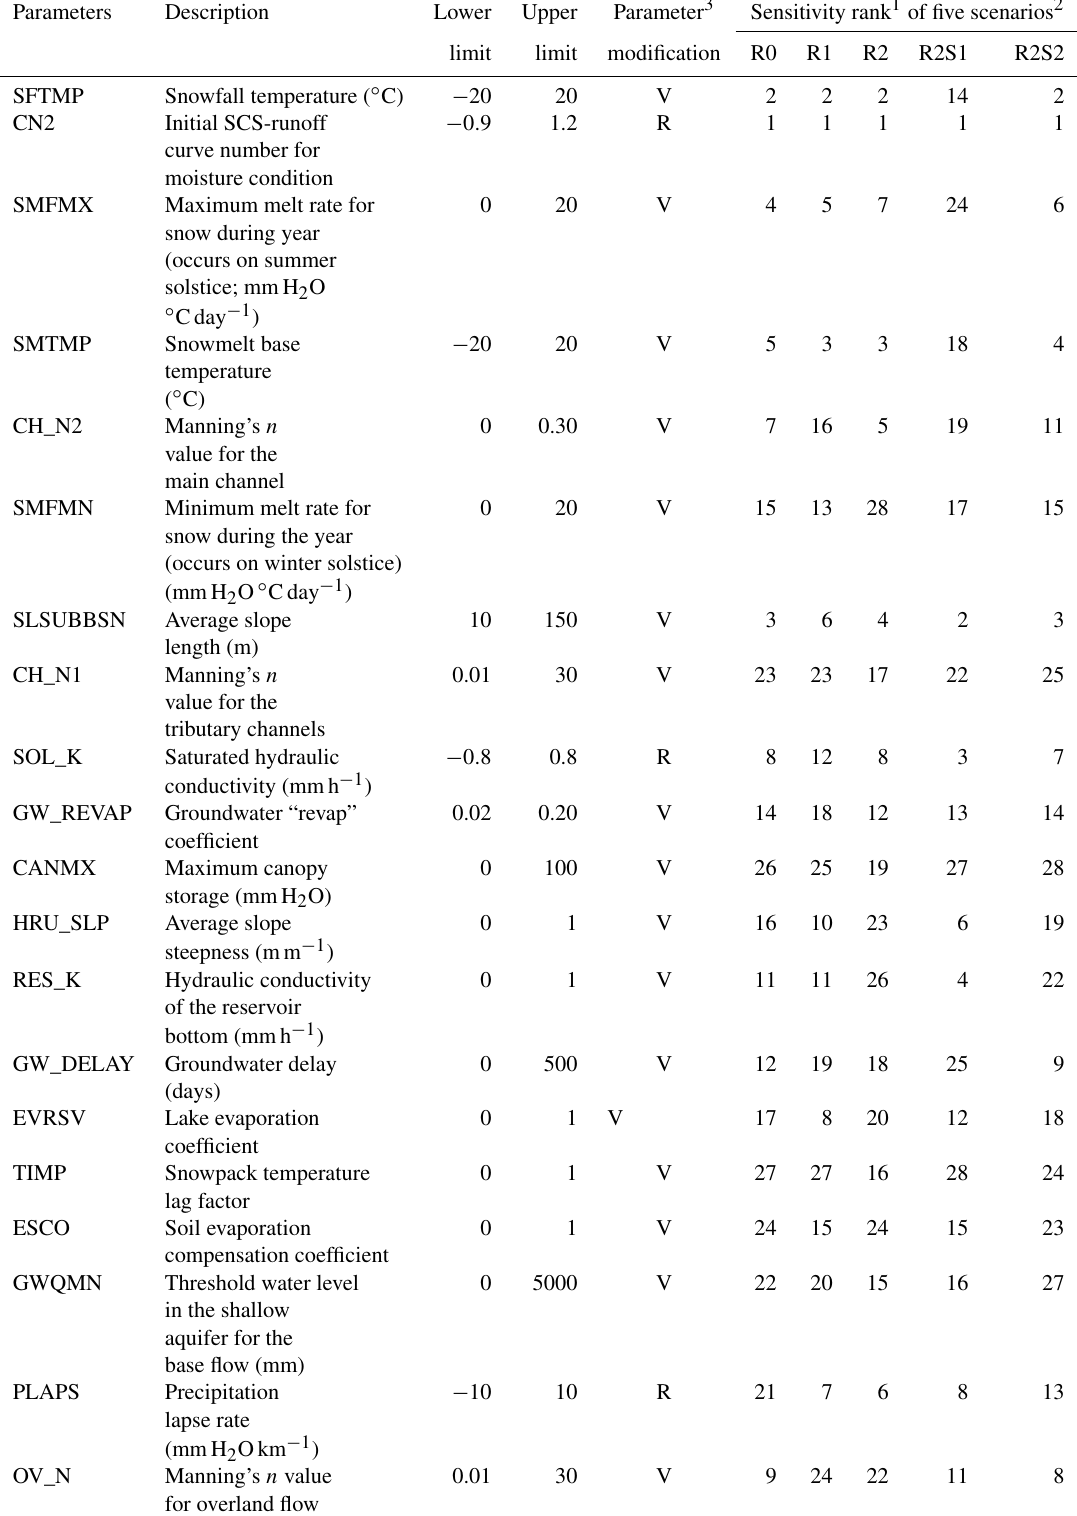
Table 3. Parameter sensitivity analysis under various scenarios.